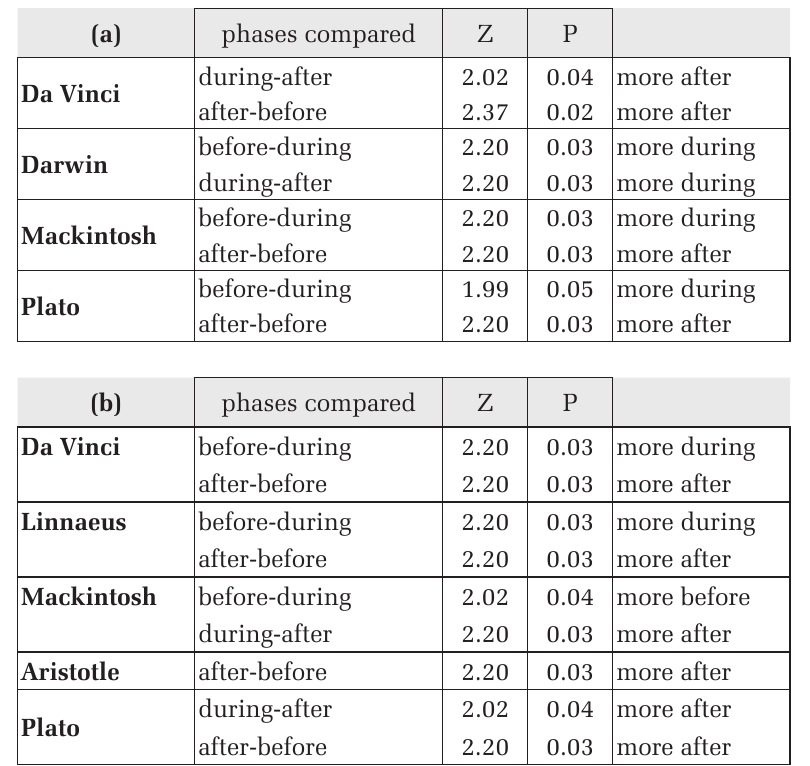
Fig. 13. Box and whisker plots for the calls given by the test subjects in the two conditions. Boxes show the interquartile range; the box for the observers is divided by the median value. Whiskers indicate the largest and smallest Tab. 1. Results for the comparison of the average number of calls all birds produced before, during and after the separation of certain individuals for (a) condition 1 and (b) condition 2.